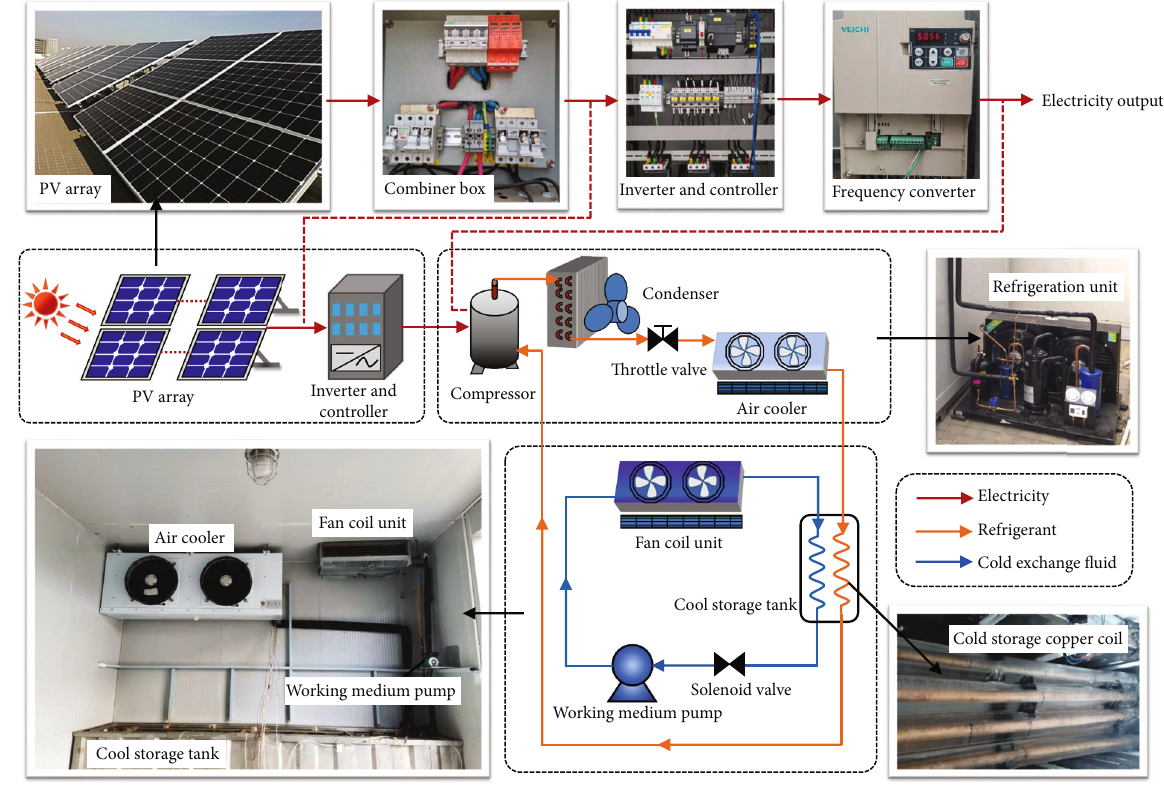
Figure 1: Schematic diagram of the photovoltaic refrigerated warehouse system with ice thermal energy